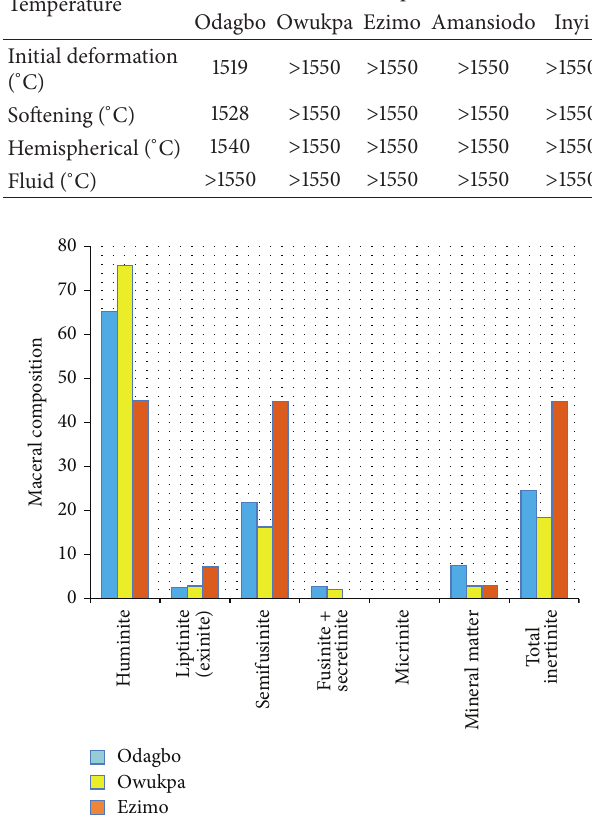
Figure 3: Petrographic analyses.